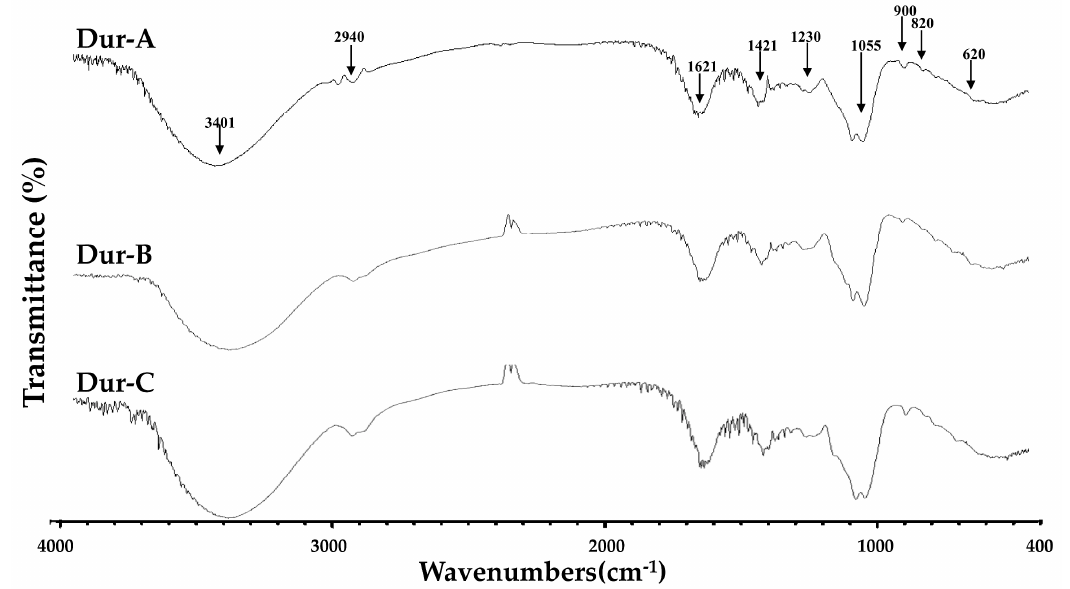
Figure 1. FTIR spectra for Dur-A, Dur-B, and Dur-C. Absorption bands at 3401, 2940, 1621, 1421, 1230, 1055, 900, 820, and 620 cm − 1 are indicated. 1055, 900, 820, and 620 cm − 1 are